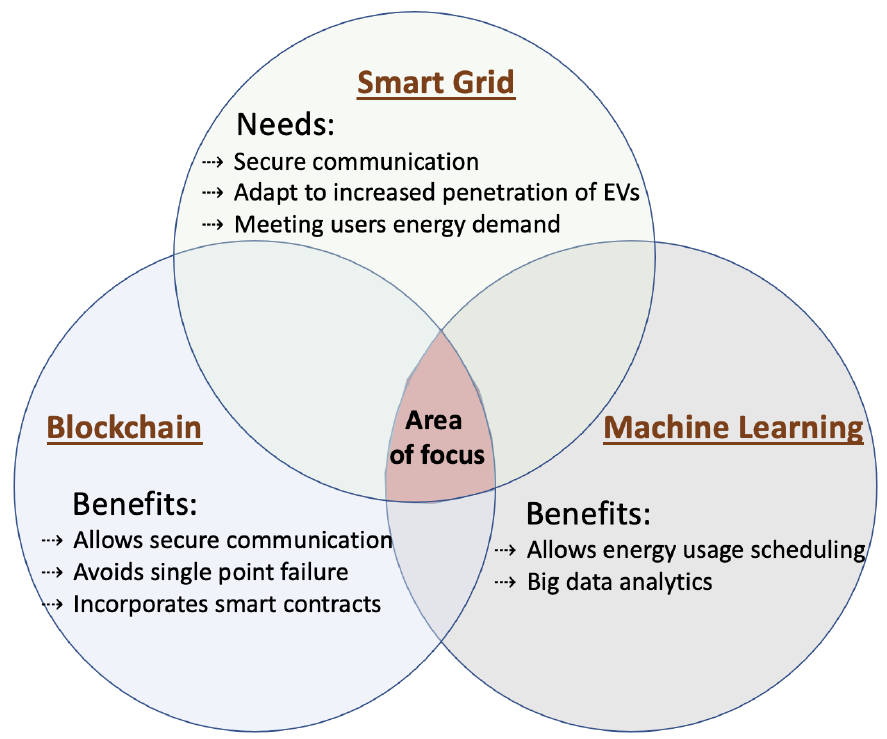
Figure 1. Scope of the